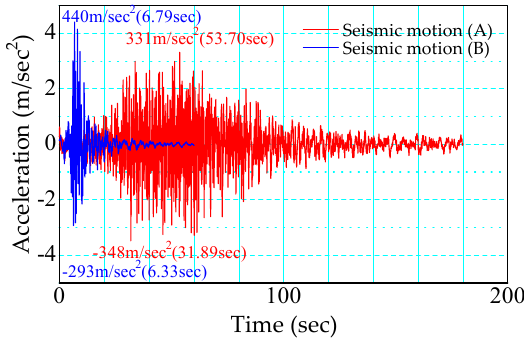
Figure 9. Input seismic motion for analysis: seismic motions (A) and (B).